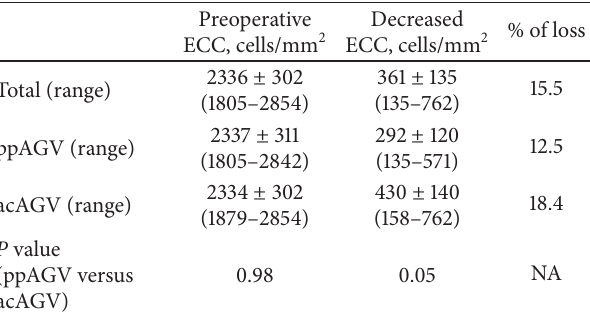
Table 3: Comparison of endothelial cell loss at postoperative 18 months between ppAGV and acAGV groups.